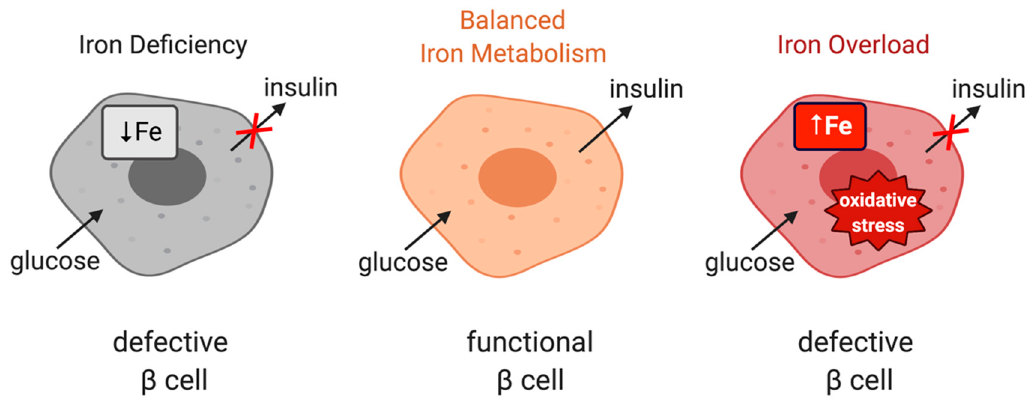
Figure 4. The role of iron in the physiological function of pancreatic β cells. Balanced iron metabolism is critical for proper glucose-stimulated insulin production. Iron deficiency as well as iron overload impair insulin expression.